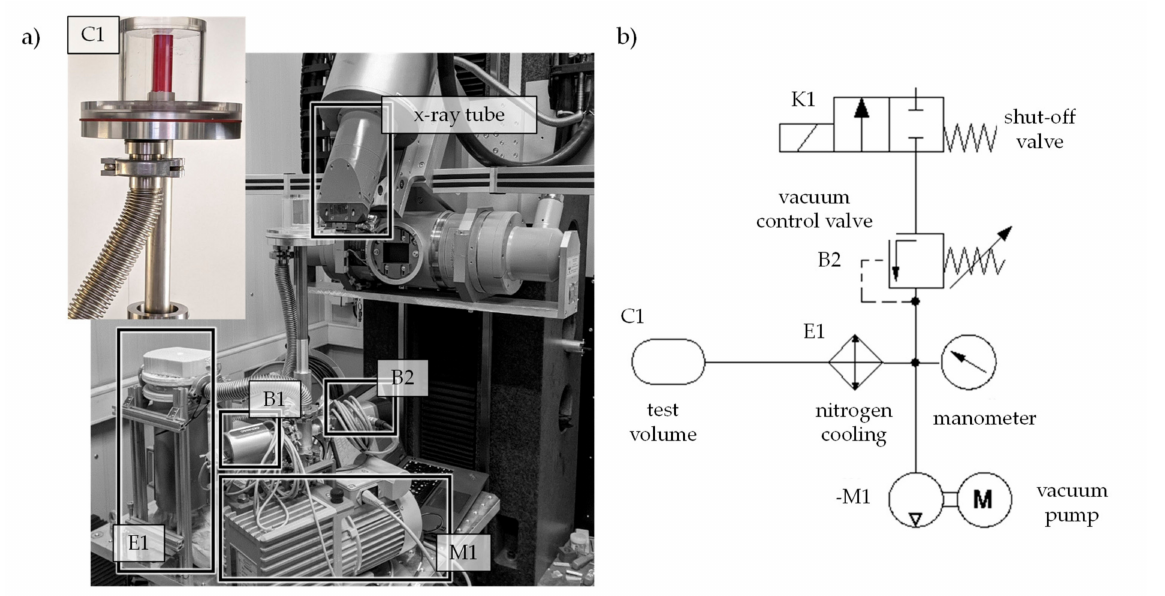
Figure 2. Test setup: ( a ) installation in the in situ radiographical and computed tomography; ( b ) schematic diagram.